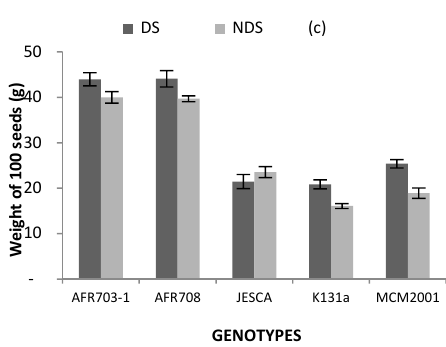
Figure 3. Interaction between genotypes and drought conditions on ( a ) pods plant − 1 ; ( b ) seeds on a plant and ( c ) weight of 100 seeds. (Bars over the mean indicate standard error). #: numbers, DF: drought stress, and NDS: non-drought stress.